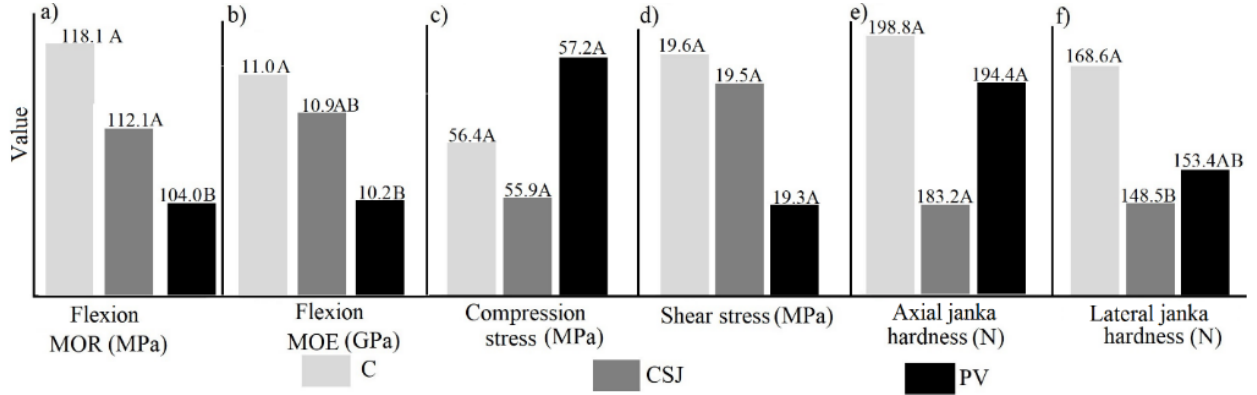
Figure 3. Mechanical properties at 8-years-old among native provenances of Dipteryx panamensis in Costa Rica: Module of rupture-MOR in flexure test ( a ), module elasticity-MOE in flexure test ( b ), compression stress ( c ), shear stress ( d ), axial janka hardness ( e ) and lateral janka hardness ( f ). Note: Different letters indicate statistically significant differences at 99% among provenances. Differences among families of the same provenance also reflected a high variation (Table 3). In the MOR in the bending test, the 2- and 3-family of the C provenance presented the lowest values. In the CSJ provenance, the lowest value was observed in the 10-family and the 1-family had the highest value. In the PV provenance, the 8-family had the lowest MOR value (Table 3). The MOE in the bending test showed no statistically